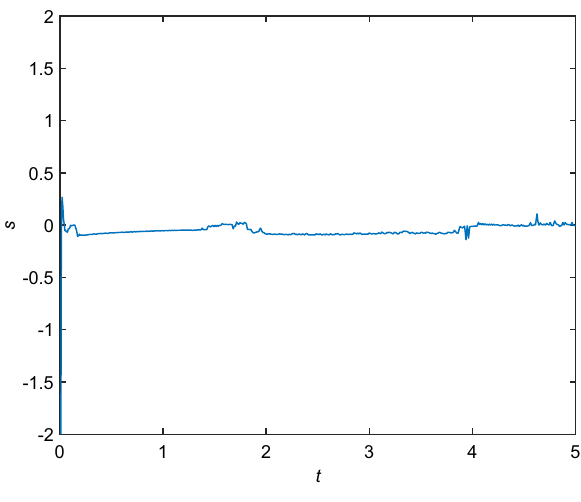
Fig. 7 The phase diagram on the x 1 − y 1 − z 1 ( x 2 − y 2 − z 2 ) space